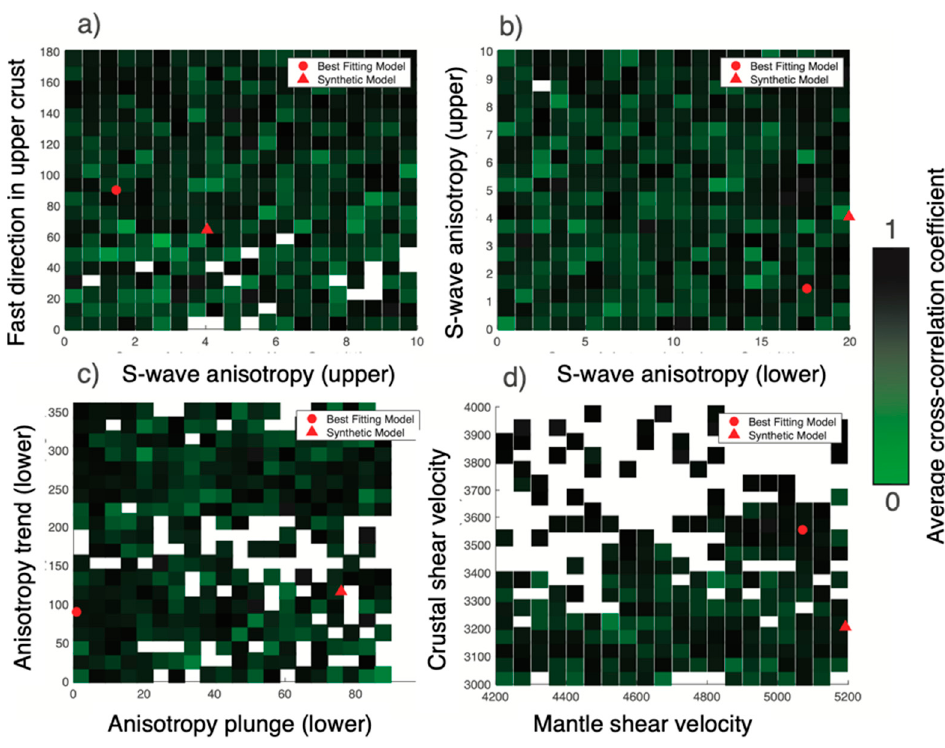
Figure A3. Results from the synthetic test of higher lower crustal anisotropy. ( a ) Fast direction (azimuth) versus shear-wave anisotropy in the upper crust (%). ( b ) Shear-wave anisotropy in the upper crust (%) versus shear-wave anisotropy in the lower crust (%). ( c ) Trend (degree) versus plunge (degree) of lower crustal anisotropy. ( d ) Crustal versus mantle shear-wave velocity (m/s). Note that the agreement between the synthetic model and the best-fitting model was noticeably worse than the first synthetic test.